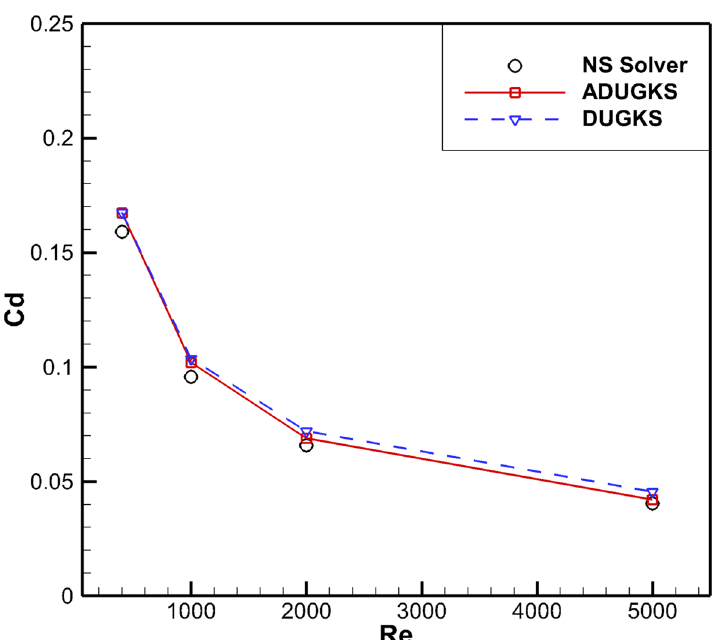
Fig. 11 Drag coefficient of the flat plate with respect to the Reynolds number in the continuum flow